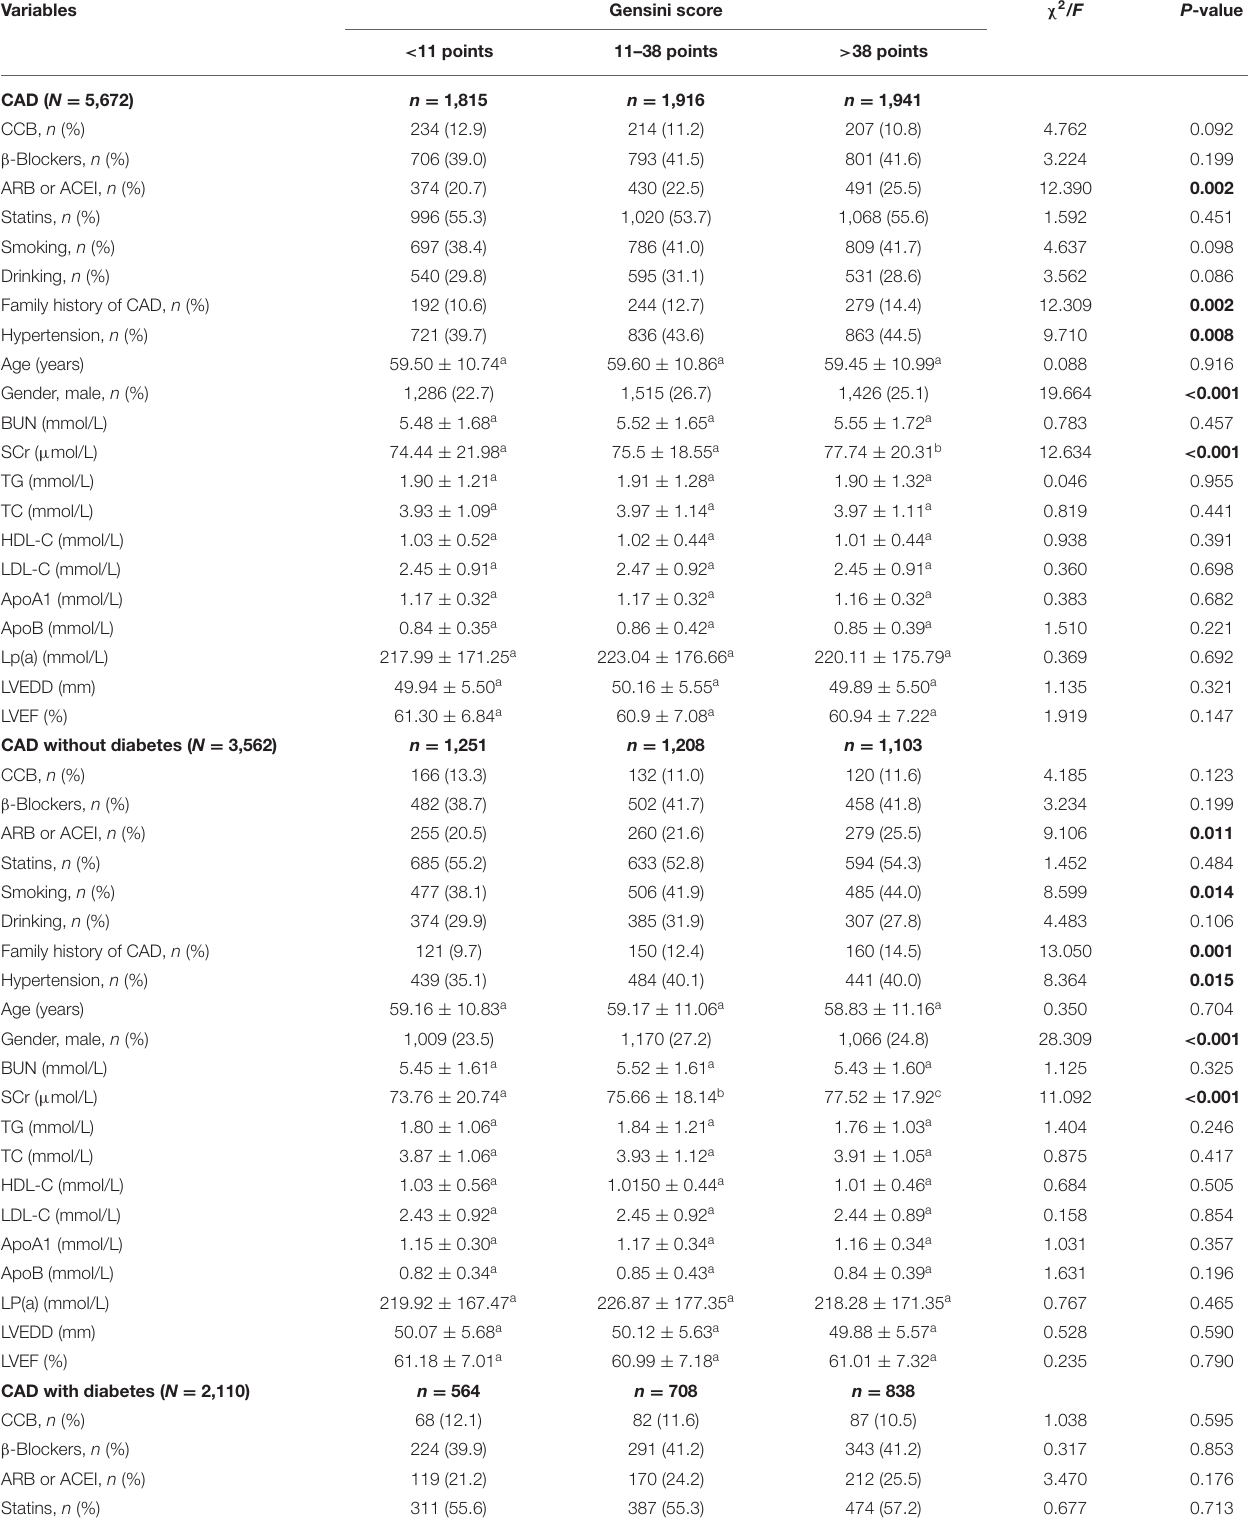
TABLE 1 | Baseline characteristics of